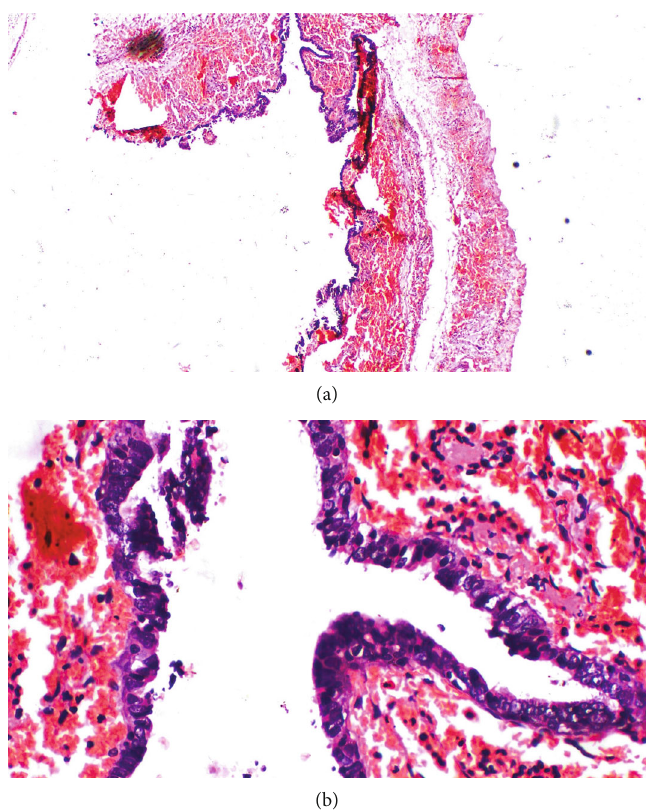
Figure 4: (a) Low and (b) high power views of the epididymal cyst wall with columnar epithelium showing congestion and